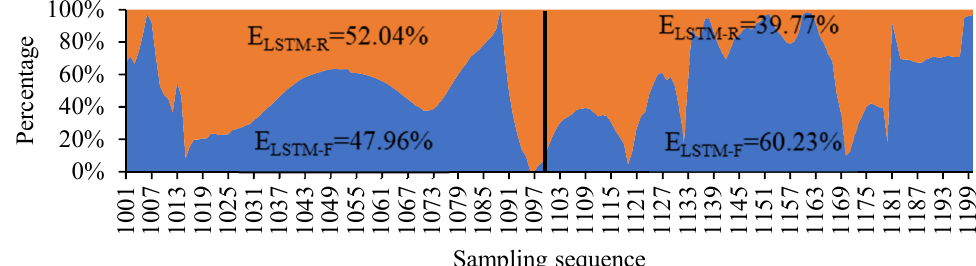
Figure 7. Percentage stacked area chart.